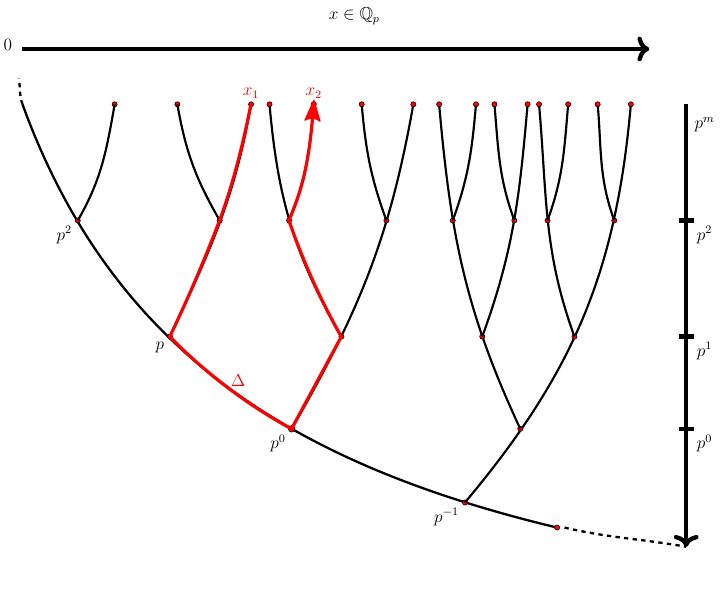
Figure 2 . A Wilson line connecting two points at the